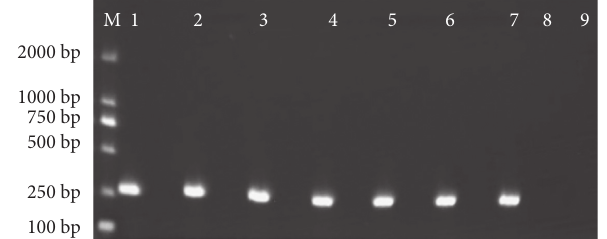
Figure 5: The PCR test for genomic DNA reference materials of no. 9–15. M , DNA marker D (100 ∼ 2000bp); lanes 1–7, PCR results of no. 9–15, respectively; lane 8, negative control; and lane 9, blank control.